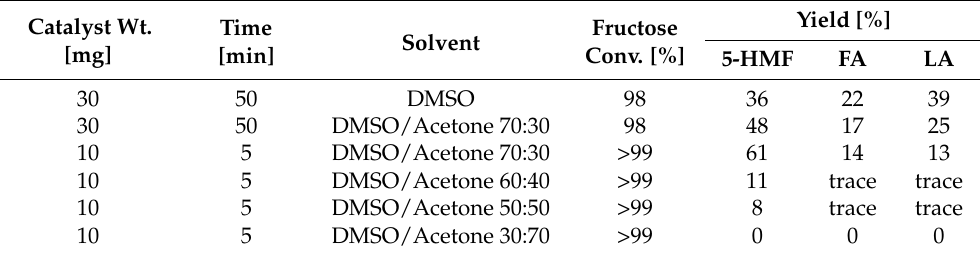
Table 4. Solvent effect of 5-HMF production from fructose over MIL-101(Cr)-SO 3 H(3) ([H + ] 0.009 mmol). Reaction conditions: MW via the standard power mode, 100 mg fructose (0.56 mmol), 3 mL solvent,